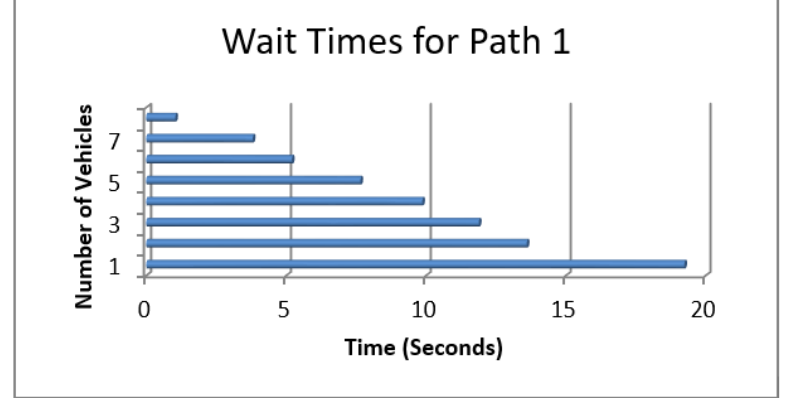
Figure 7. Wait Times for each vehicle for t2=30 seconds